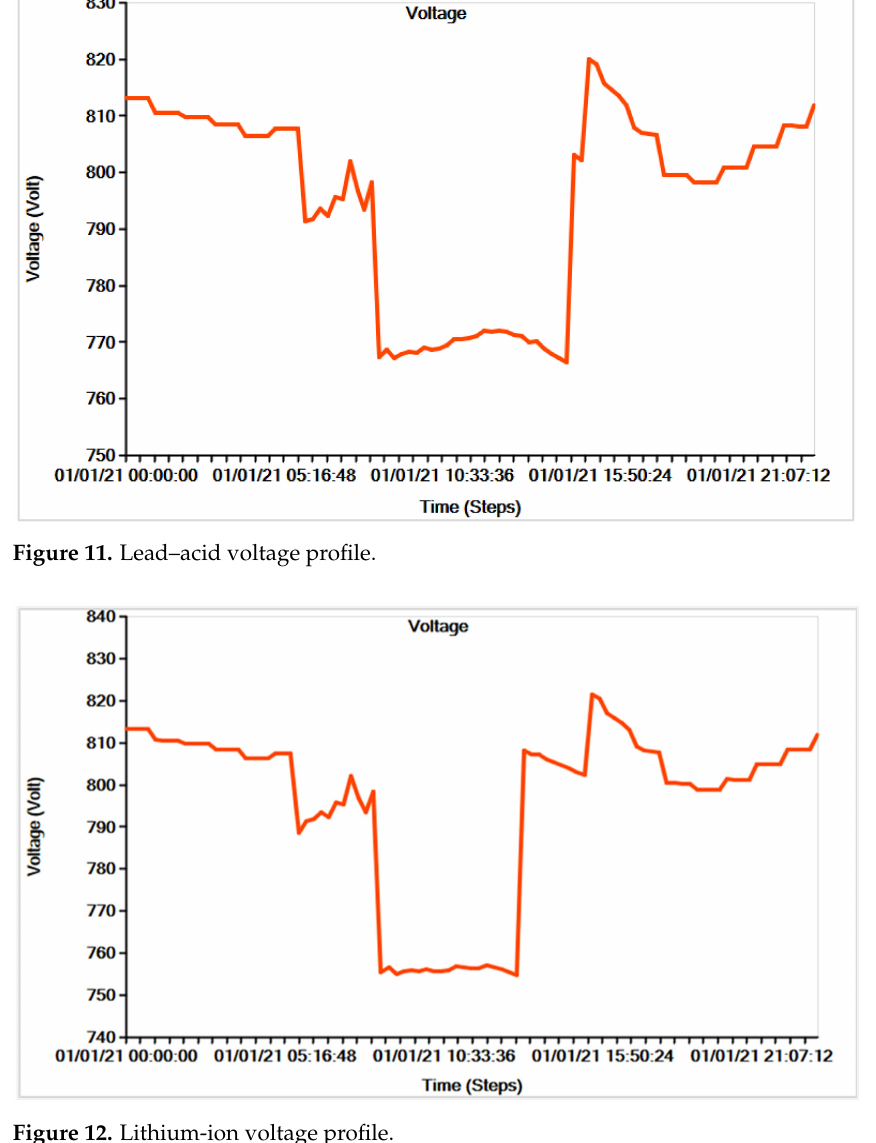
Figure 12. Lithium-ion voltage profile.